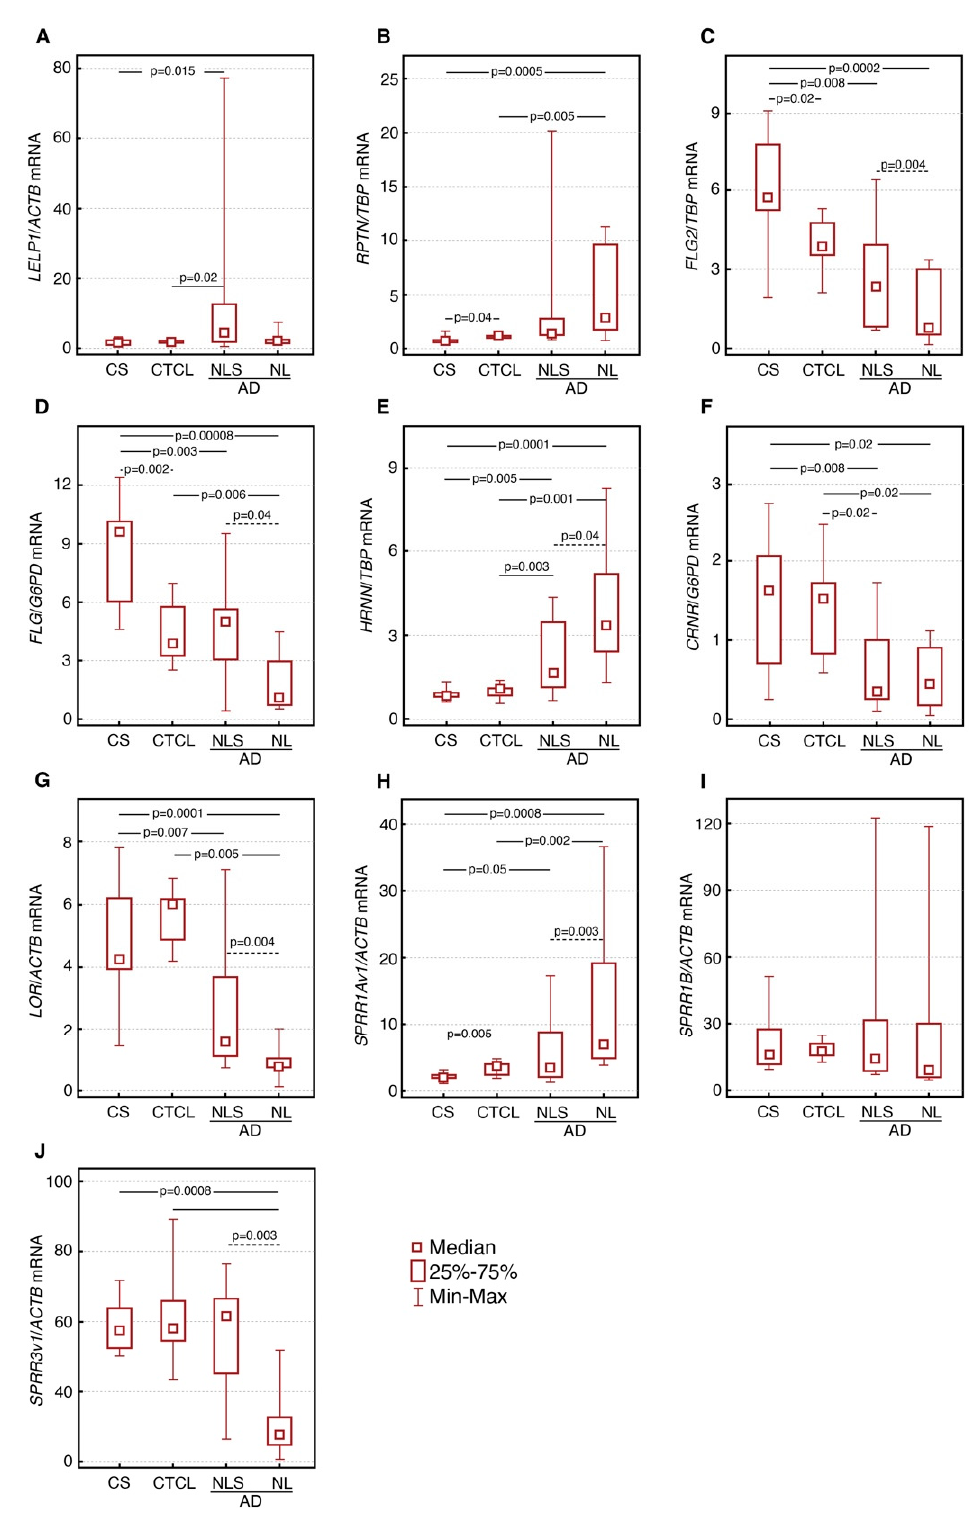
Figure 1. Levels of LELP1 ( A ) , RPTN ( B ), FLG2 ( C ), FLG ( D ) , HRNR ( E ), CRNN ( F ) , LOR ( G ) , SPRR1Av1 ( H ) , SPRR1B ( I ) and SPRR3v1 ( J ) transcripts in skin of healthy subjects (CS), cutaneous T-cell lymphomas (CTCL), lesional atopic dermatitis (LS AD) and nonlesional AD (NLS AD).